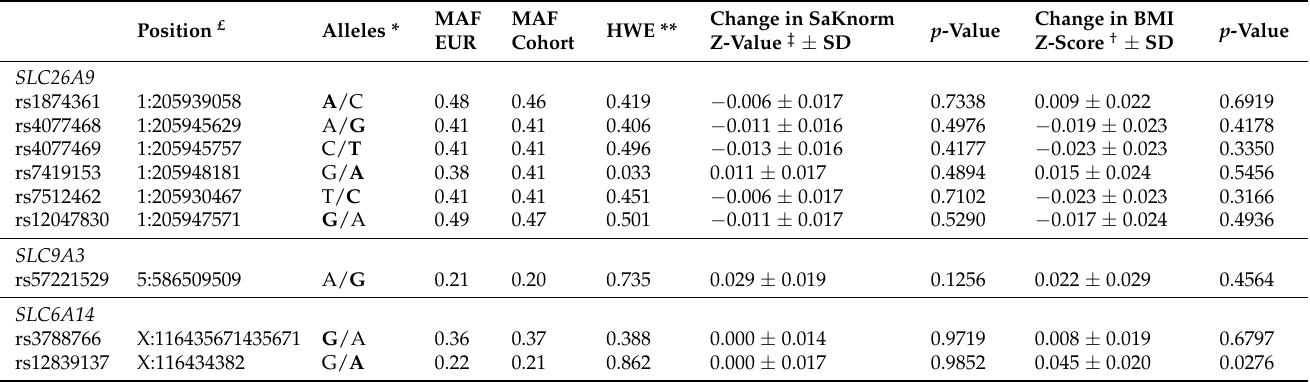
Table 3. Lung function and nutritional response of combined lumacaftor/ivacaftor therapy,